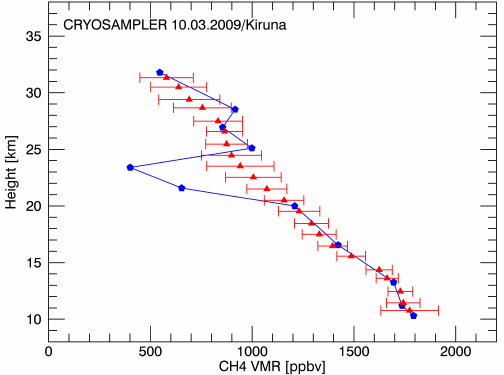
Figure 1. Comparison of CH 4 profile retrieved from B45 (1 April 2011, from Kiruna Sweden, 68 ◦ N) and the corresponding mean MIPAS E profile based on the trajectory matching results. Blue dots: cryosampler measurements. Blue line: interpolated CH 4 pro- file from cryosampler (BONBON). Red triangle: mean CH 4 mix- ing ratio values of MIPAS-E. Red error bars: standard deviation of matched Envisat data.